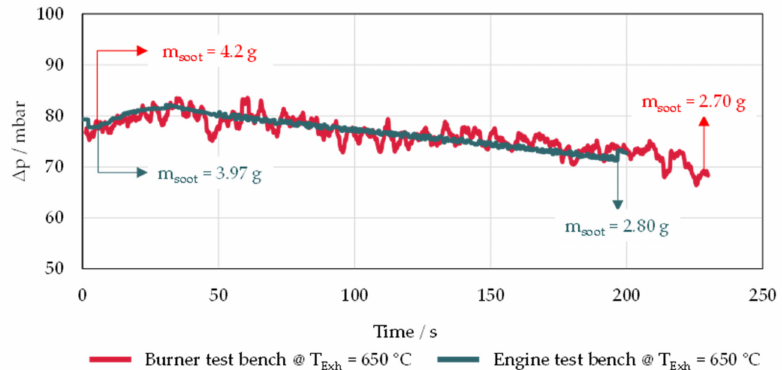
Figure 15. Pressure drop across the GPF during an active regeneration event—burner test bench vs. engine test